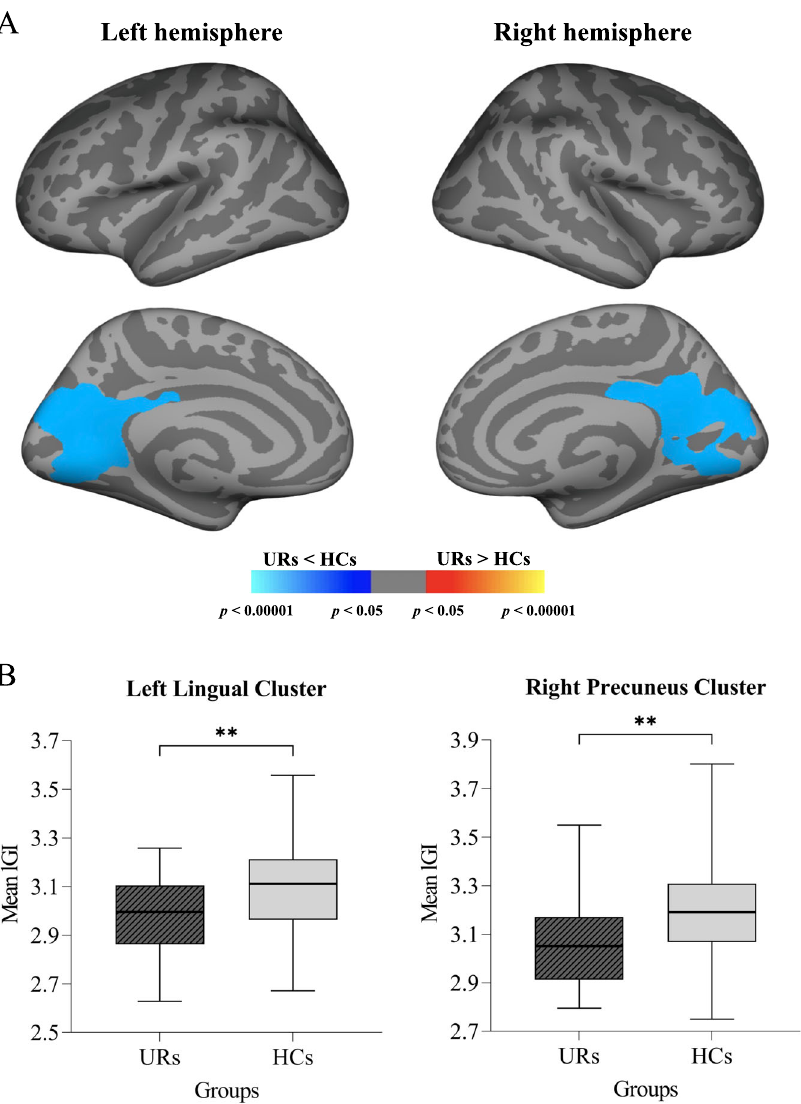
Fig. 1 Group differences in the local gyri fi cation index (lGI) between the unaffected relatives (URs) and healthy controls (HCs). A Statistical maps of the left and right hemispheres are shown in the lateral and medial views, respectively. The maps are shown for the clusters with signi fi cantly reduced lGI in the URs after clusterwise correction for multiple comparisons ( p < 0.05). B Bar graph of mean lGI values extracted from the left lingual cluster and right precuneus cluster showing signi fi cant group differences. The error bars indicate 95% con fi dence intervals. ** p <